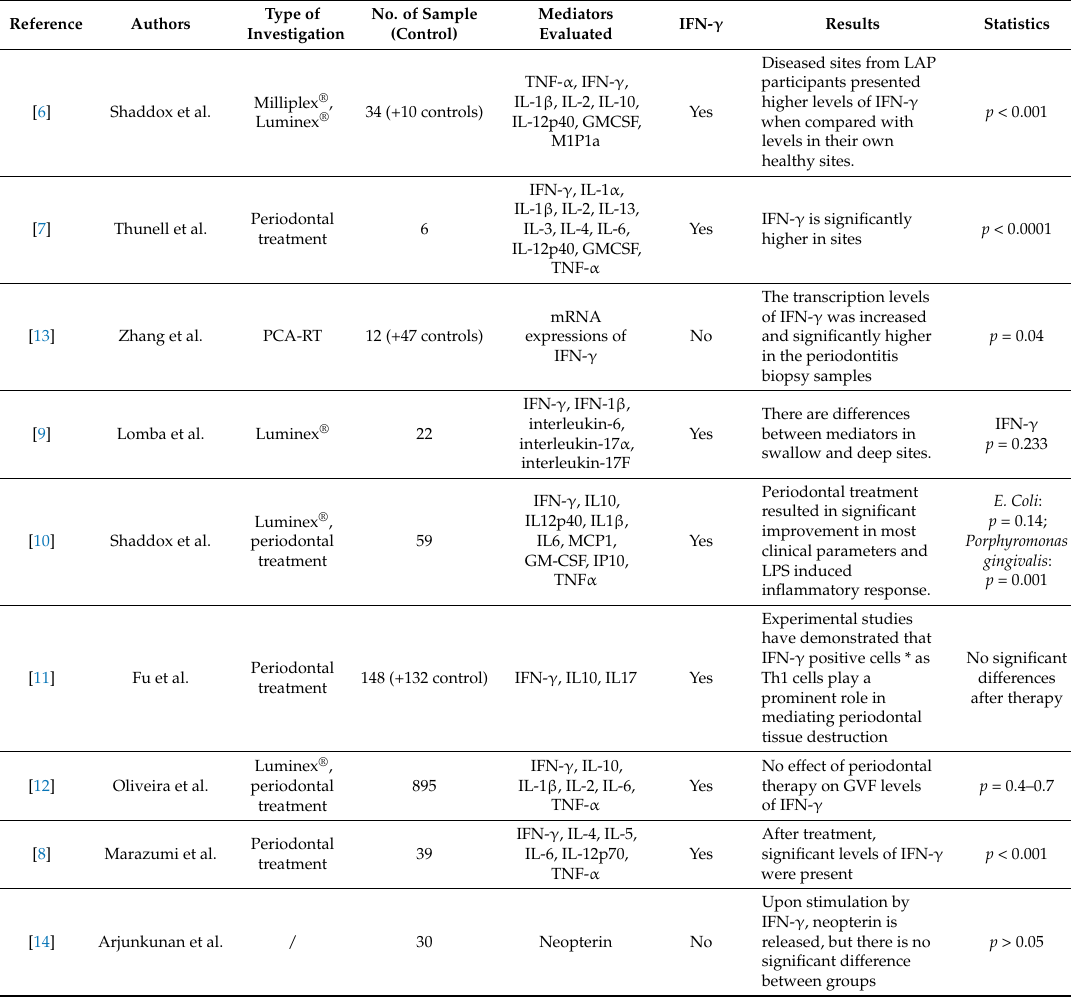
Table 1. Summary of studies involved in the present